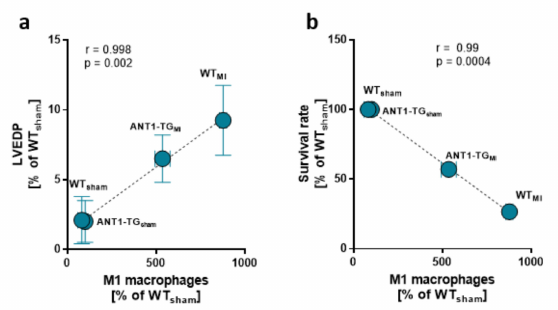
Figure 4. Myocardial macrophage levels and hemodynamics. The mean ± SEM of M1 macrophage levels found in the sham and infarcted hearts of WT and ANT1-TG rats was positively correlated with the means of ( a ) left ventricular end-diastolic pressure (LVEDP) and was negatively correlated with the ( b ) survival rate.